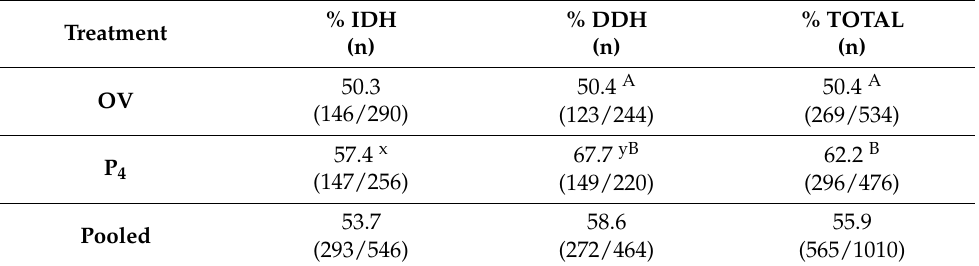
Table 1. In rows, descriptive statistics relative to the efficiency of the first AI recorded on primipa- rous buffaloes synchronized by Ovsynch (OV) or Progesterone based treatment (P 4 ), and in col- umns, undergoing AI during periods characterized by Increasing Daylight Hours (IDH) and De- creasing Daylight Hours (DDH).